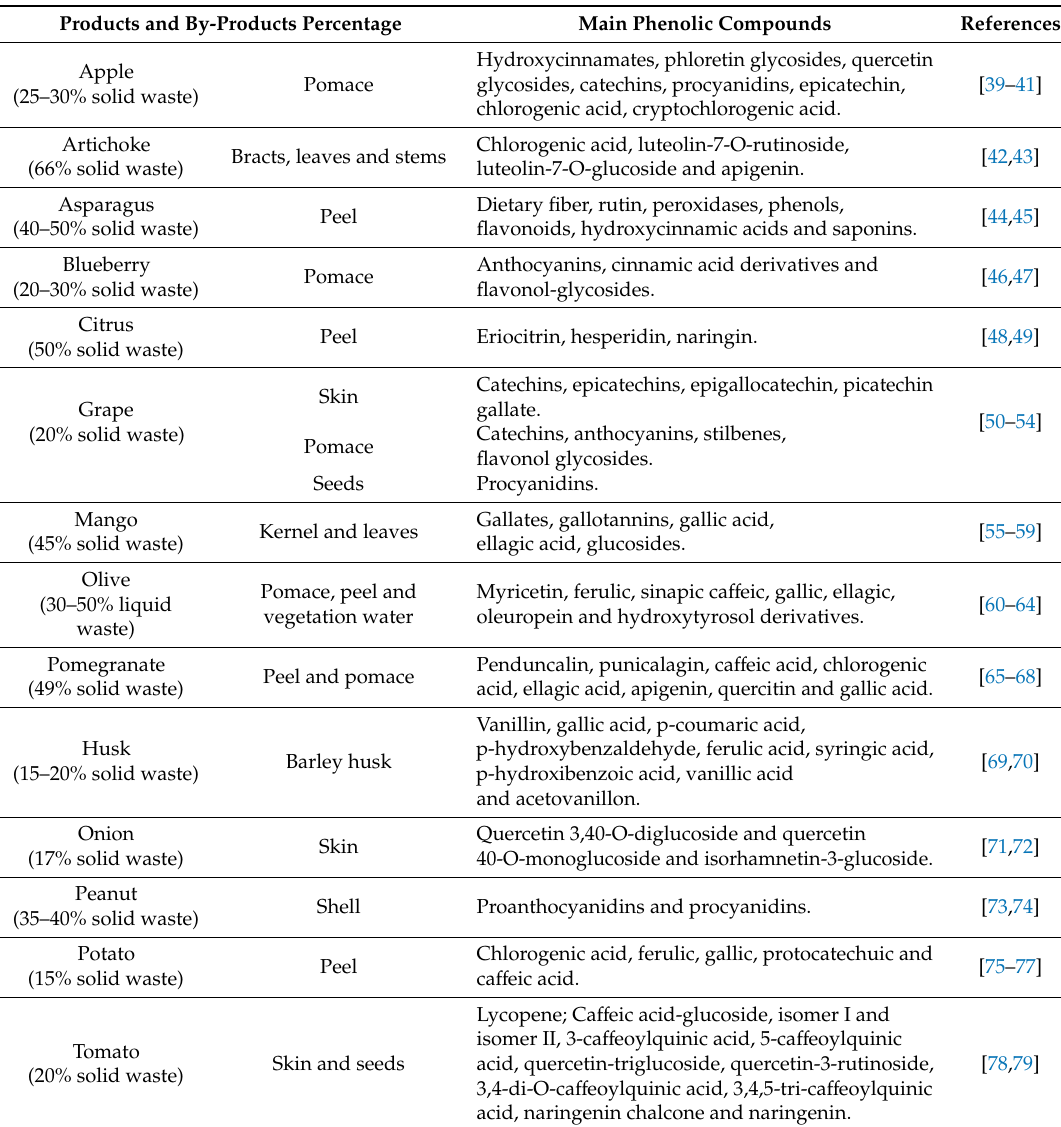
Table 1. Fruit and vegetable by-products and main phenolic